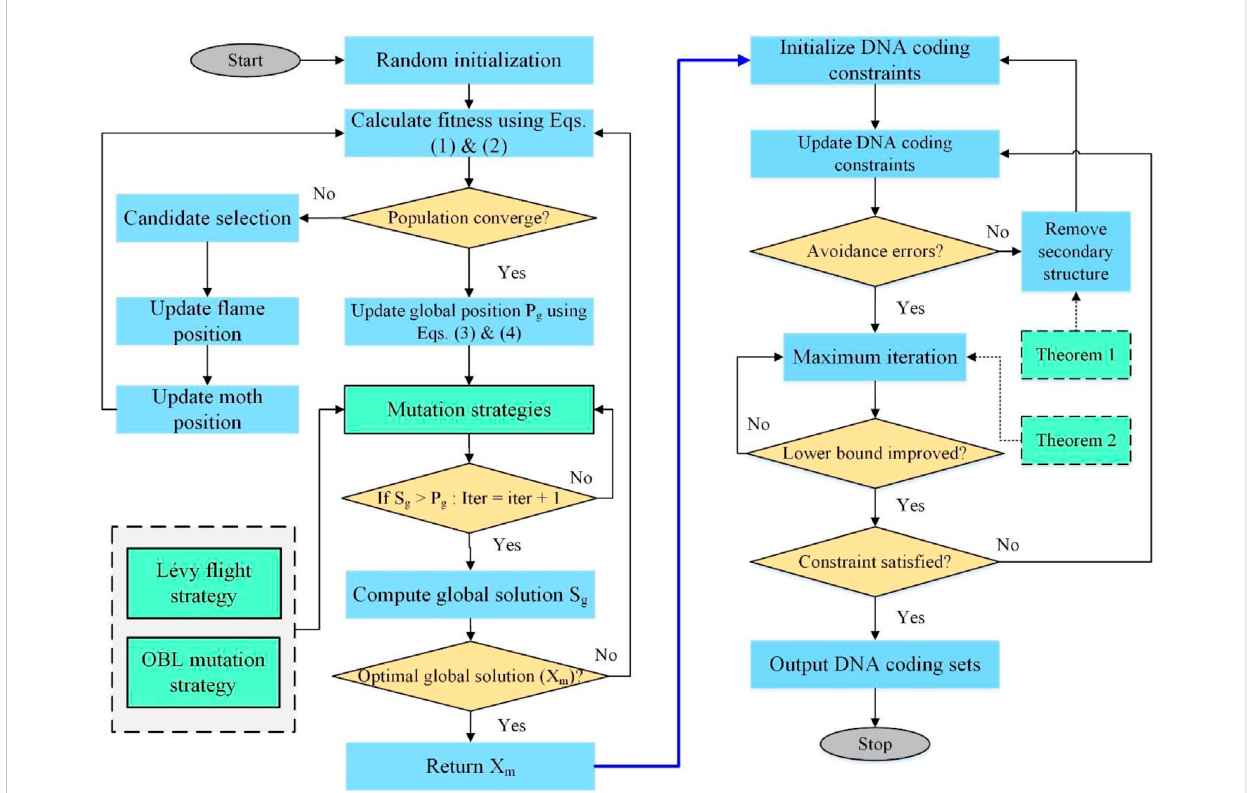
FIGURE 2 Schematic of the improved MFOS evolutionary approach with combinatorial DNA coding